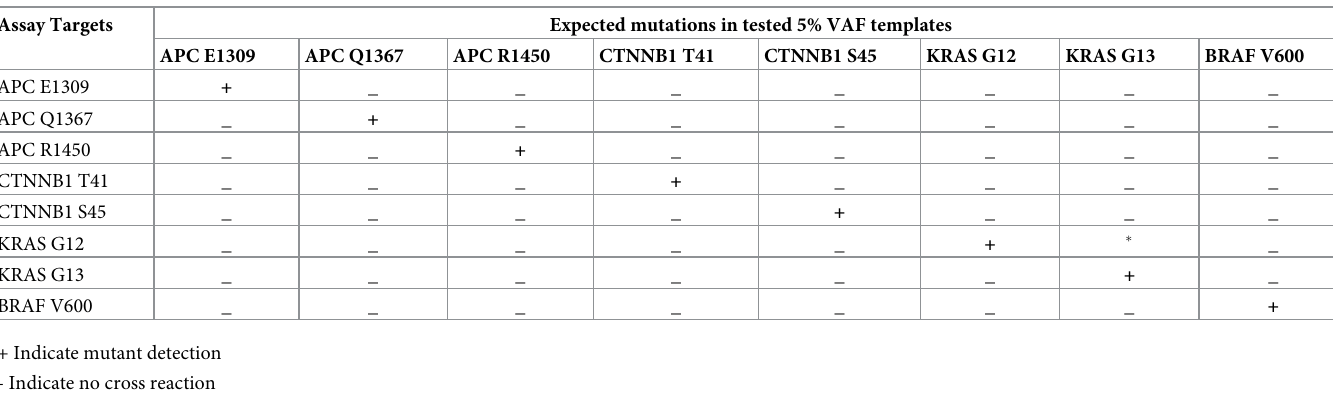
Table 3. Assay analytical specificity–the assay cross reactivity. Assay Targets